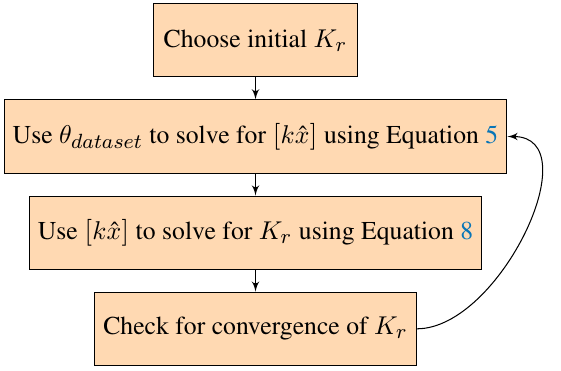
Figure 3. Flow chart of the Orbital Velocity method where K r is the reflection coefficient, θ dataset is the ) 2